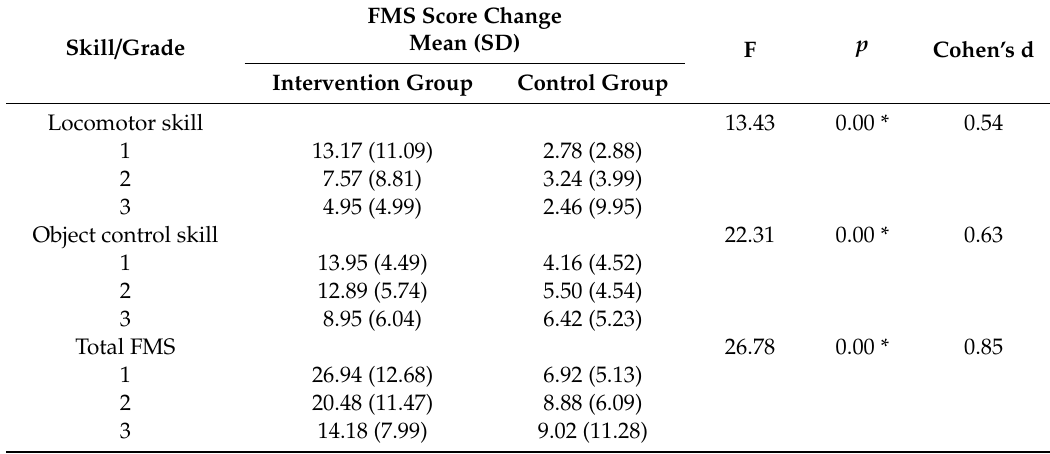
Table 3. Changes on FMS score between intervention and control group by grade ( n = 560).